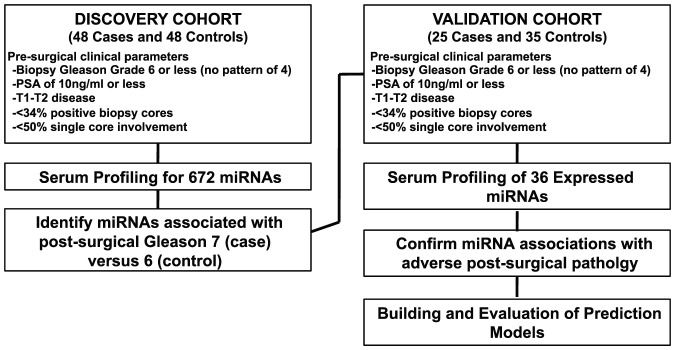
Schematic of the study design.